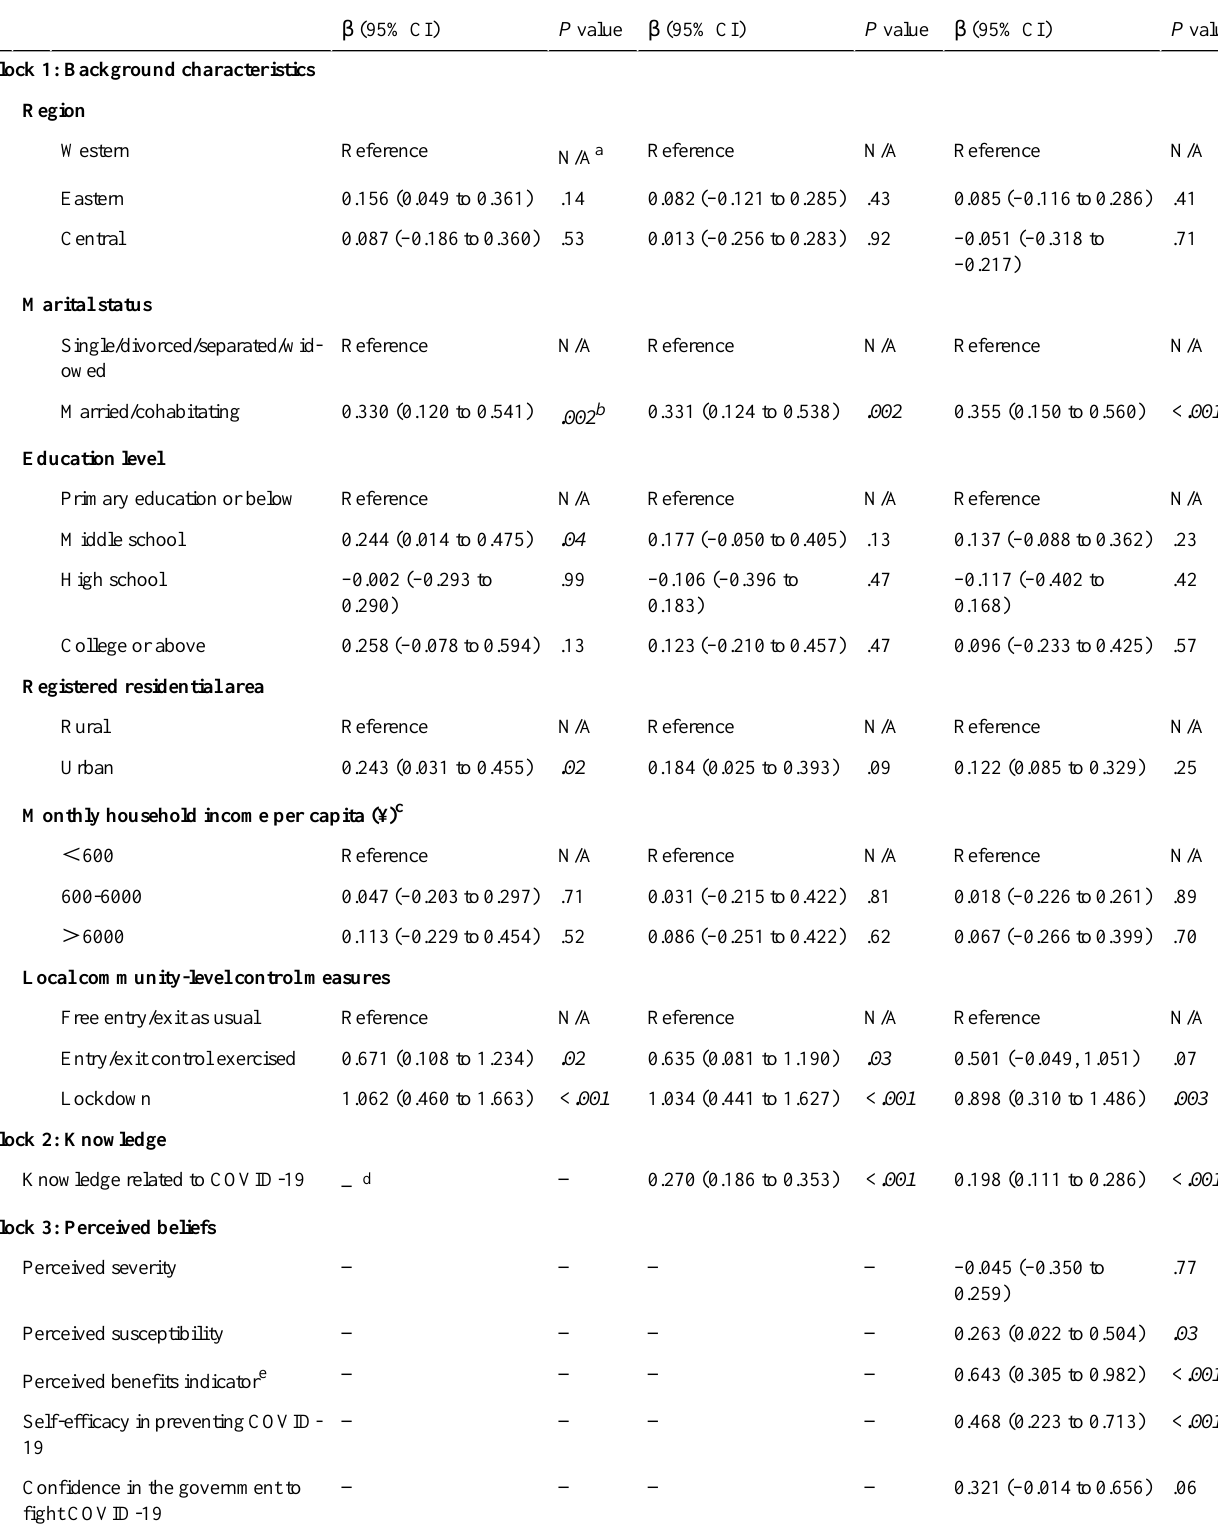
Model 3Model 2Model